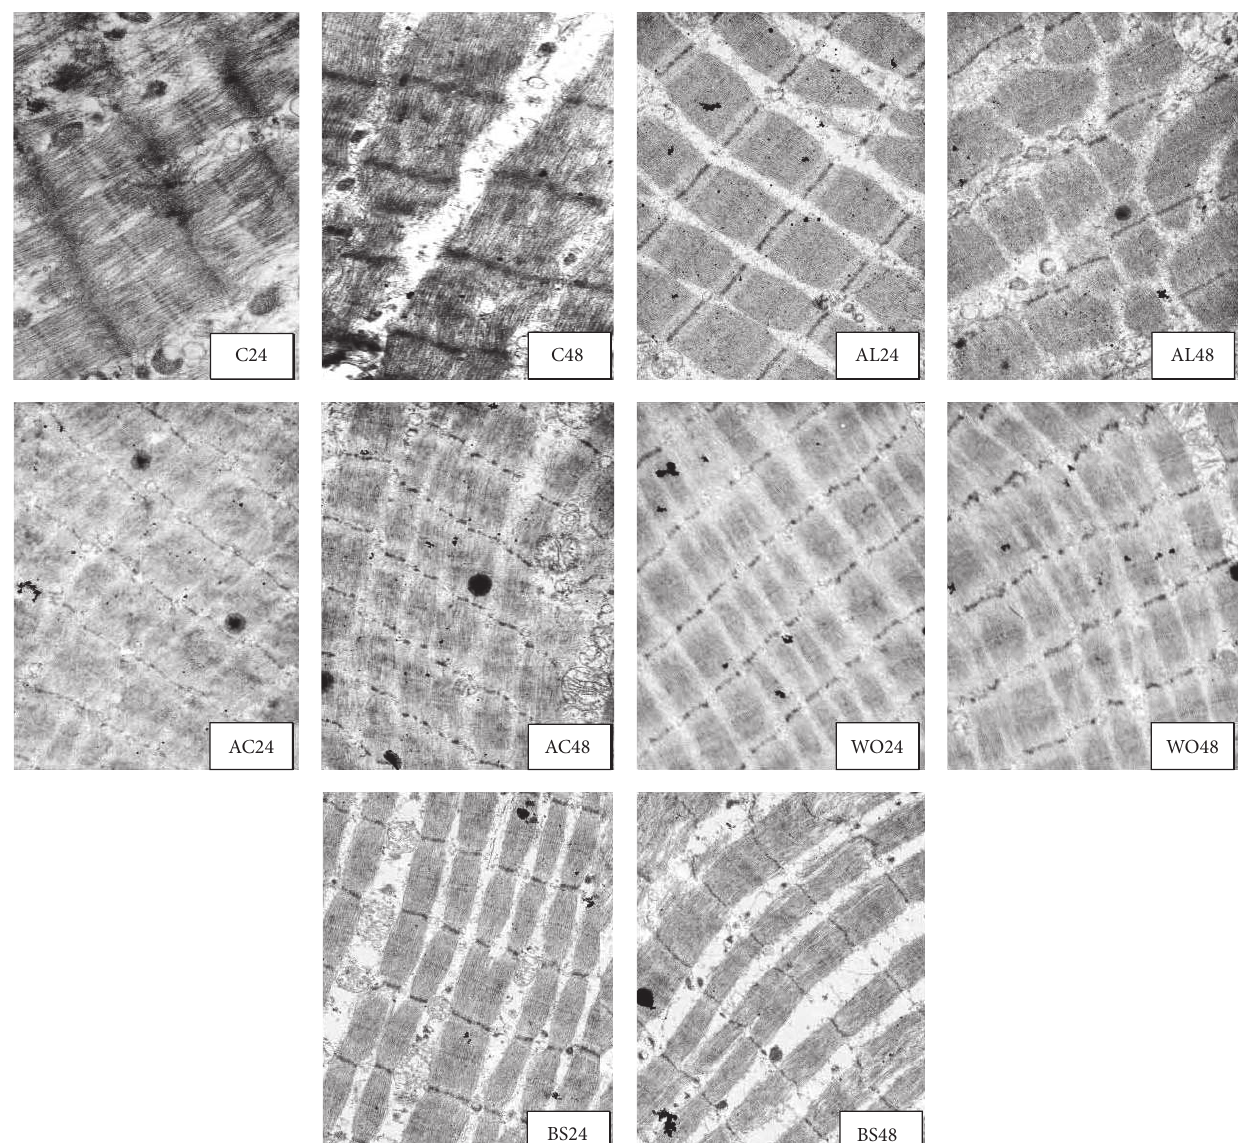
Figure 1: Electron micrographs of longitudinal section of marinated sheep ( m. Longissimus dorsi ), 12000x. C24: control sample stored at 0–4 ∘ C in air conditions for 24 h; C48: control sample stored at 0–4 ∘ C for 48 h; AL24: test sample after 24h alkaline marinating; AL48: test sample after 48h alkaline marinating; AC24: test sample after 24 h acid marinating; AC48: test sample after 48 h acid marinating; WO24: test sample after 24 h water-oil marinating; WO48: test sample after 48h water-oil marinating; BS24: test sample after 24 h brine soaking; BS48: test sample after 48 h brine